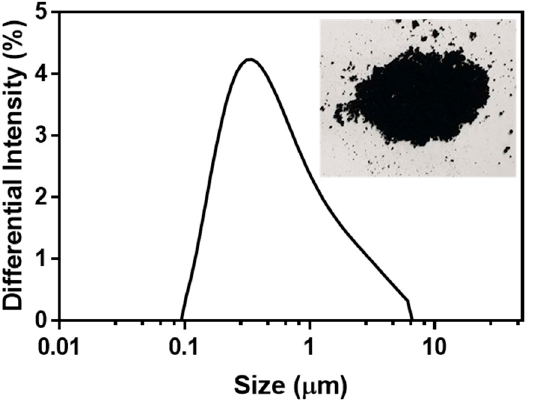
Figure 1. Graph of size distribution by dynamic light scattering (DLS) analysis and image of KDP20. The differential intensity distribution (%) of KDP20 is presented by the diameter size (µm, on a log scale). The size distribution was obtained through repeated measurements (60 times). Table 1. Polycyclic aromatic hydrocarbons (PAHs) contents of KDP20 by gas chromatography mass